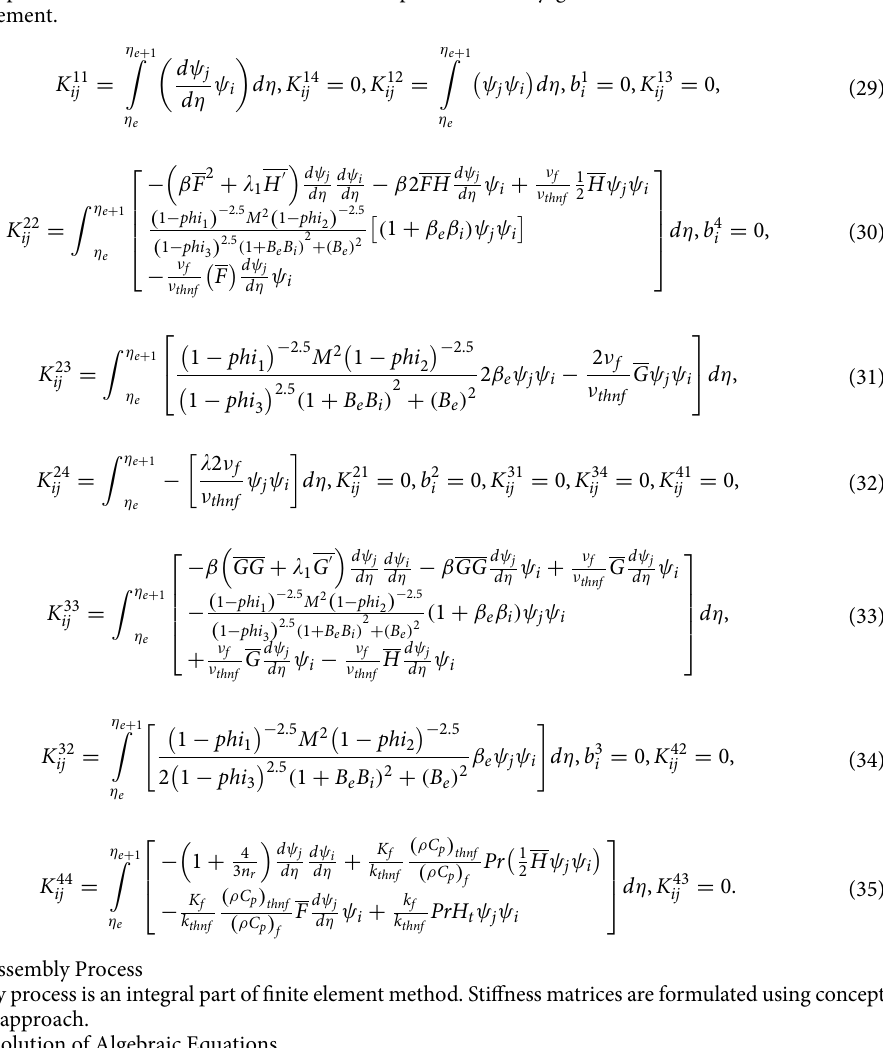
of assembly approach. Step VI Solution of Algebraic